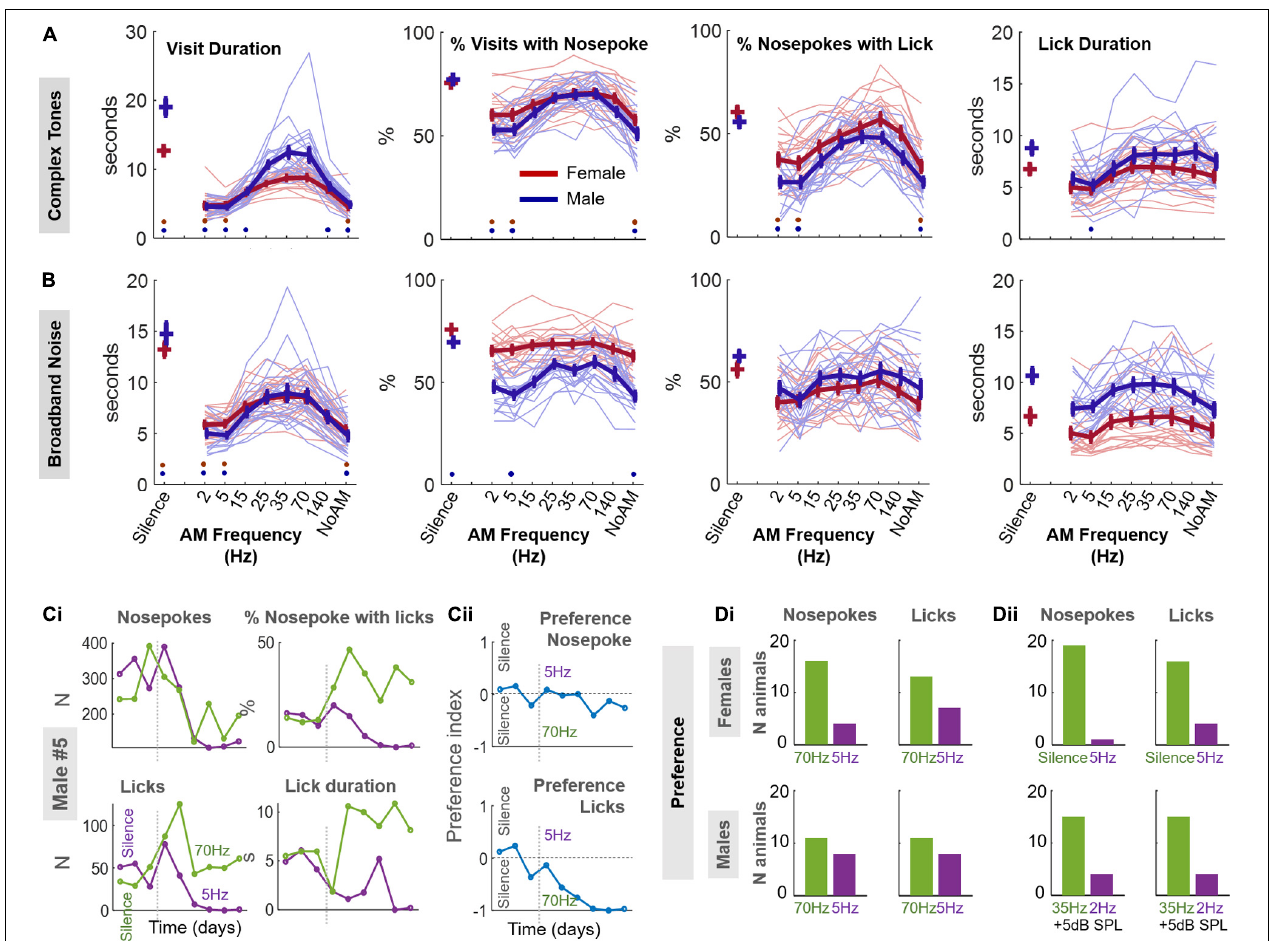
FIGURE 3 | Effects of AM sounds on mouse behavior. (A) The carrier of the AM sound is a complex tone. From extreme left to right: visit duration, percentage of visits with a nosepoke, percentage of nosepokes with a lick, and lick duration, are represented as a function of the stimulus presented (complex tone or silence). The behavior of female (red) and male (blue) animals is displayed. Thin lines are individual data while thick lines display average + / − standard error bars. Red (resp. blue) points at a given AM rate indicate a p < 0.05 for the post-hoc test (see “Materials and Methods” for ANOVA definition) between this AM rate and the 35 Hz for female (resp. male) data. (B) Same as A when the carrier is broadband noise. (C,D) Two-choice protocol. After a 3-day habituation period, each door of the experimental corner is associated with an AM complex tone (5 Hz on left door, 70 Hz on right door) for 6 days. (C) Example results for male #5. (Ci) Number of nosepokes (upper left), licks (lower left), percentage of licking for each nosepoke (upper right) and lick duration (lower right) in each door across days. Green (resp. purple) line represents the right (resp. left) door. (Cii) Preference index for nosepokes (up) and licks (down) across days, see “Materials and Methods.” (Di)